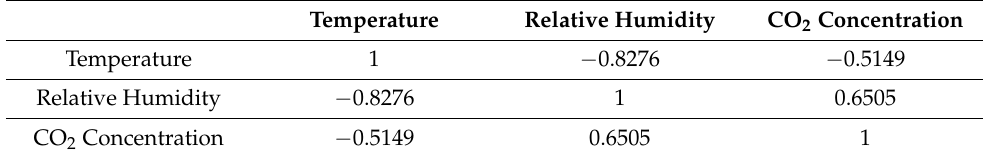
Table 2. Person’s Correlation Coefficient for rabbit house environmental variables.